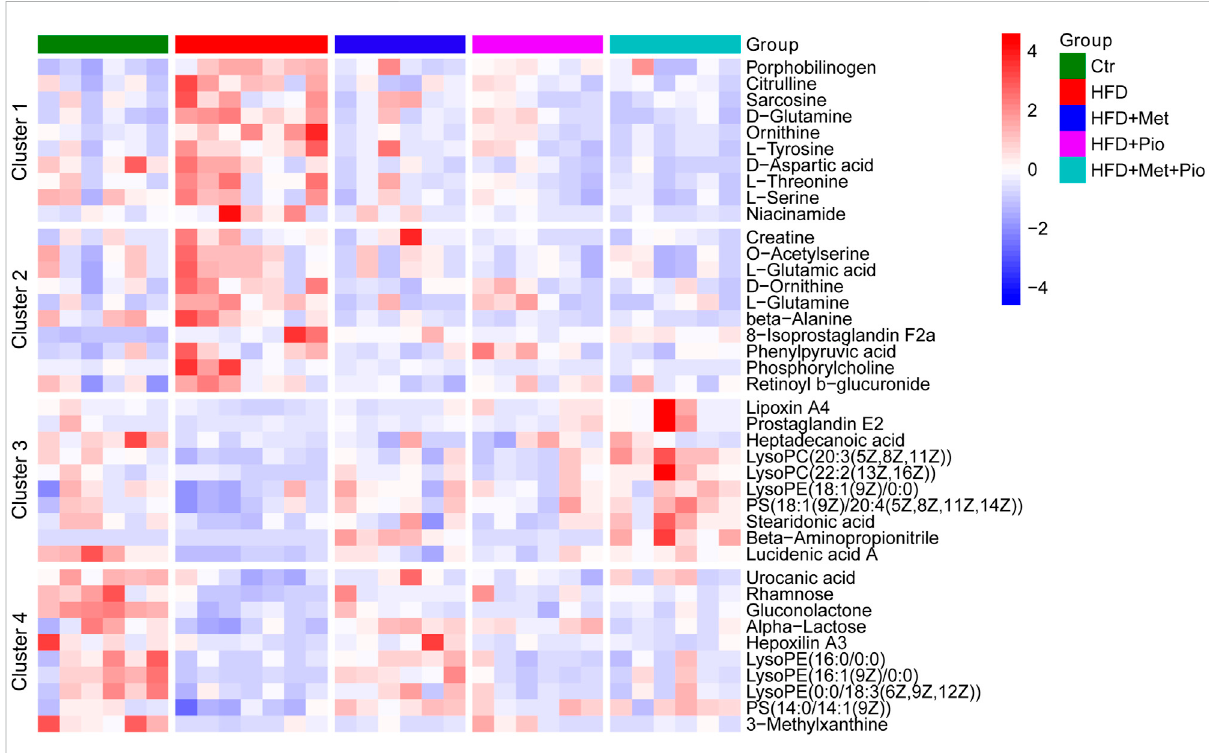
FIGURE 5 HeatmapanalysisoftherepresentativealteredgutmetabolitesinClusters1 – 4.Ctr,standardcontroldiet;HFD,high-fatdiet;HFD+Met,high-fat